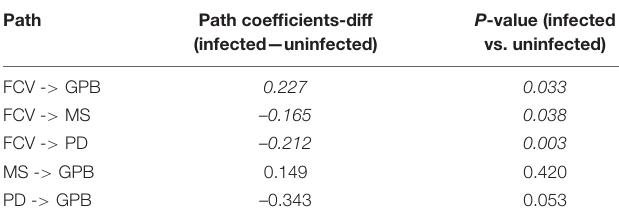
TABLE 8 | Multi-group